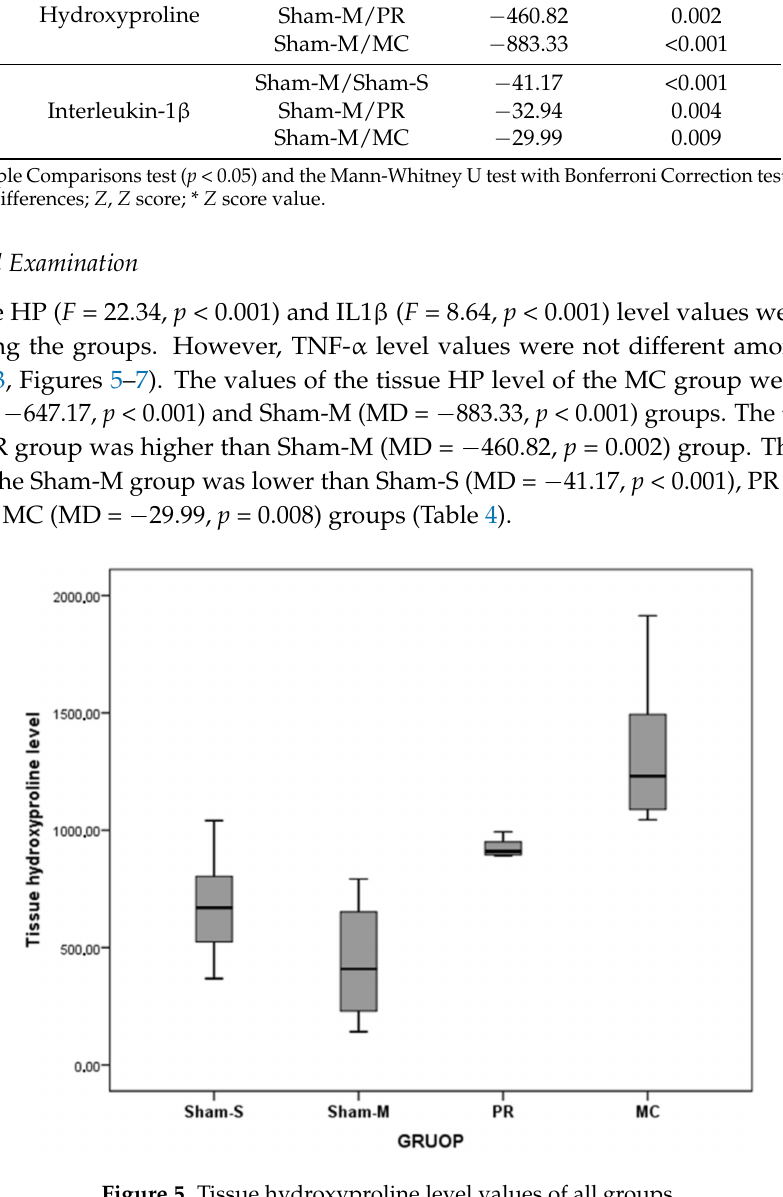
Figure 5. Tissue hydroxyproline level values of all